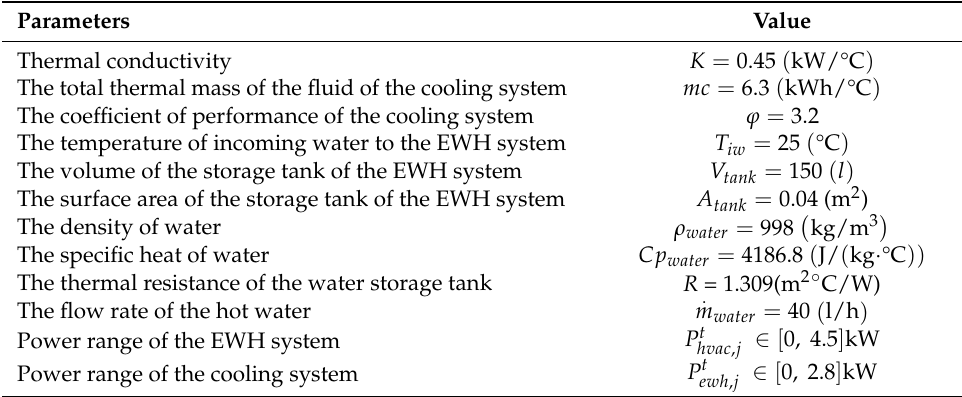
Figure 3. The ambient temperature for a typical day in June in Newark, NJ, USA. Table 4. The parameters of the case